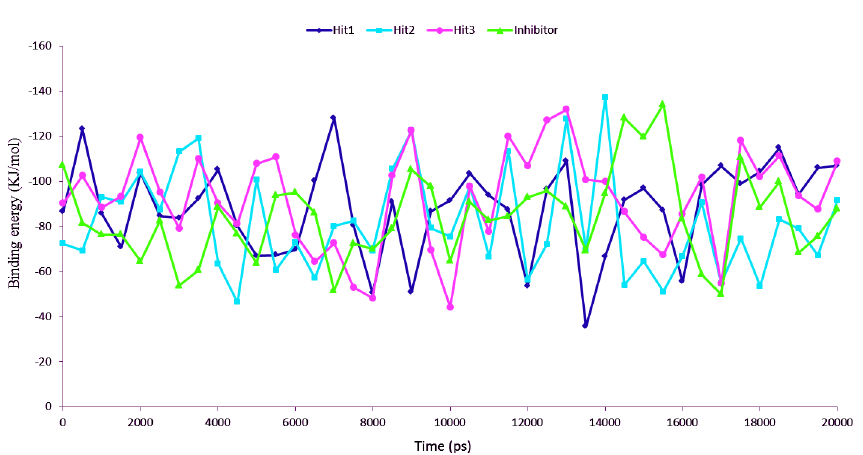
Fig 12. MM/PBSA estimated binding free energy of Btk and hit 1/hit 2/hit 3/ reference inhibitor complex throughout simulation time. Color coding; Hit 1: Blue, Hit 2: cyan, Hit 3: pink and Inhibitor: